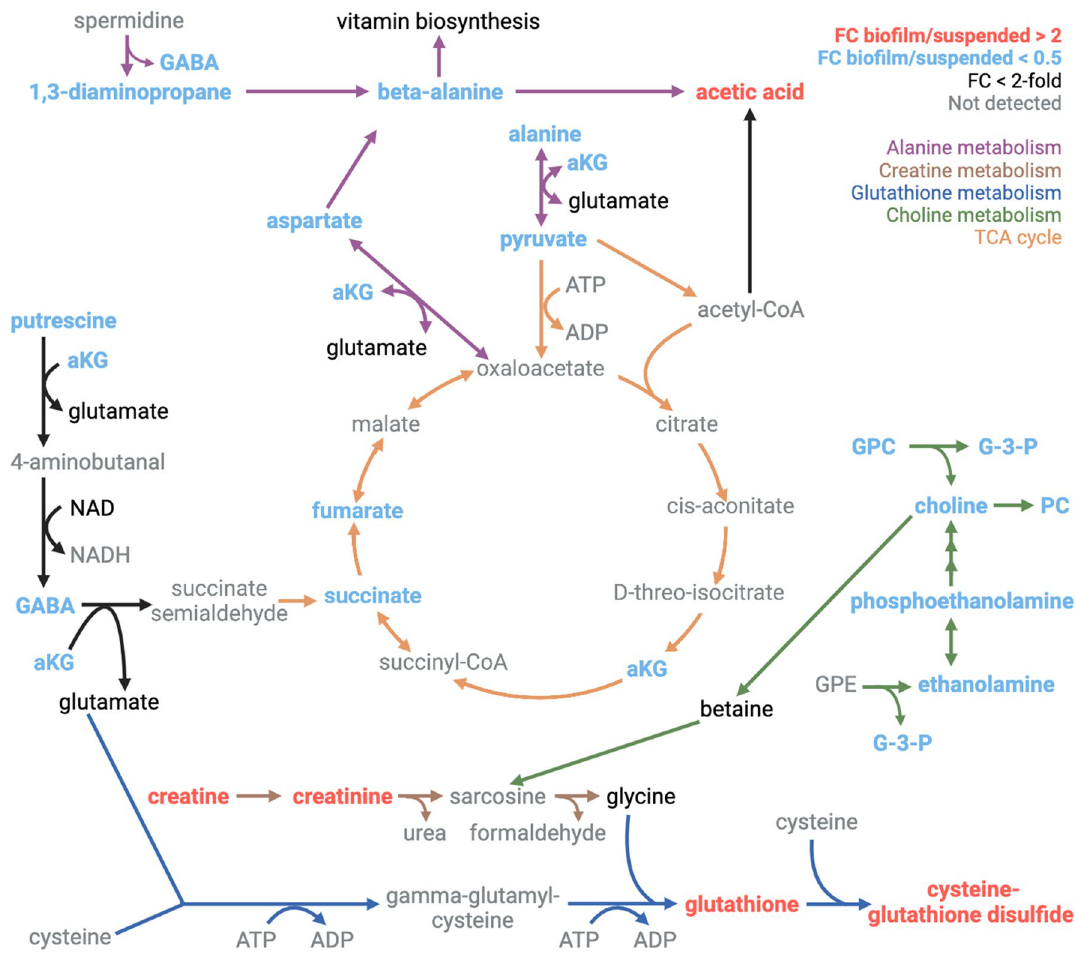
Figure 7. Metabolic pathway map displaying significant metabolite quantity differences between the suspended and lawn biofilm cultures. Metabolites with a fold change (FC) (biofilm/suspended) > 2 are red indicating higher levels in biofilm and FC < 0.5 are blue indicating higher levels in suspended culture. Pathways showing significant changes between suspended culture and biofilm have the arrows color-coded including alanine metabolism (purple), creatine metabolism (brown), glutathione metabolism (dark blue), choline metabolism (green), and the TCA cycle (orange). Metabolites that were detected but the fold change is less than two-fold are shown in black and metabolites not detected are shown in gray ( GABA gamma-aminobutyric acid, aKG alpha-ketoglutarate, ATP adenosine triphosphate, ADP adenosine diphosphate, NAD nicotinamide adenine dinucleotide, NADH nicotinamide adenine dinucleotide reduced, GPC glycerophosphocholine, G-3-P glycerol- 3-phosphate, PC phosphorylcholine, GPE